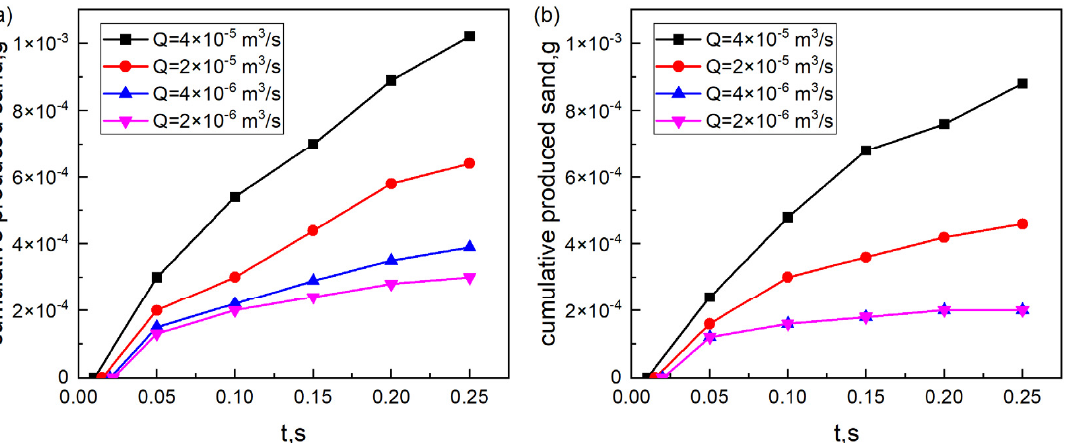
Figure 10. ( a ) porosity and normalized permeability change over time for porous media. ( b ) comparison of relative permeability for porous media at the initial and final steps.